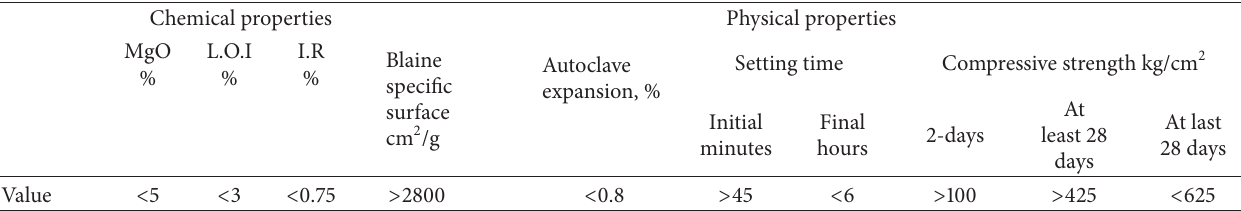
Table 2: Properties of Type I cement, according to ASTM C